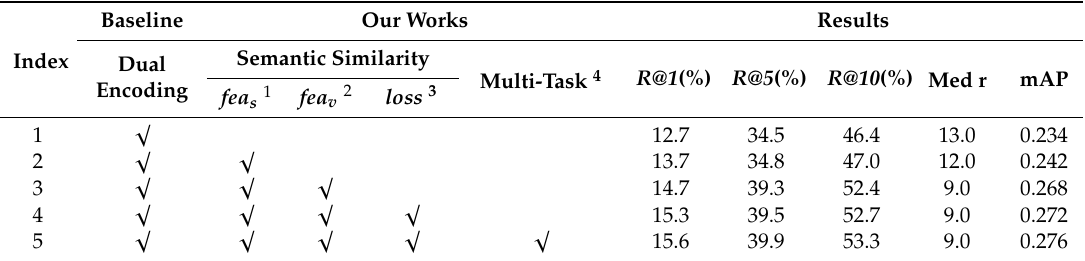
Table 1. Ablation study on the Microsoft Video Description (MSVD)